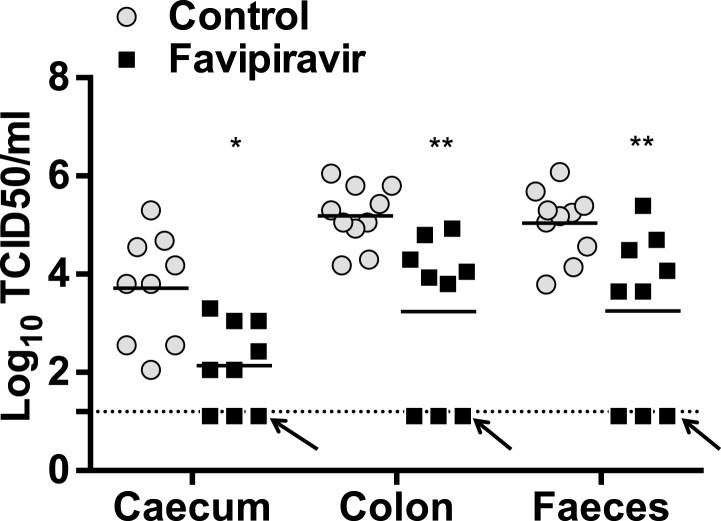
Infectious virus rebound after blind passage of faecal and tissue sample homogenates in RAW264.7 cells.Virus titres obtained after blind passage infection in RAW264.7 cells of faeces, caecum, and colon homogenates obtained from animals at treatment day 53 (Figure 5A,B). An arrow indicates samples from the same three animals that remained negative after blind passage, indicating extinction. These samples remained negative by TCID50 assay and qPCR after three consecutive blind passages.